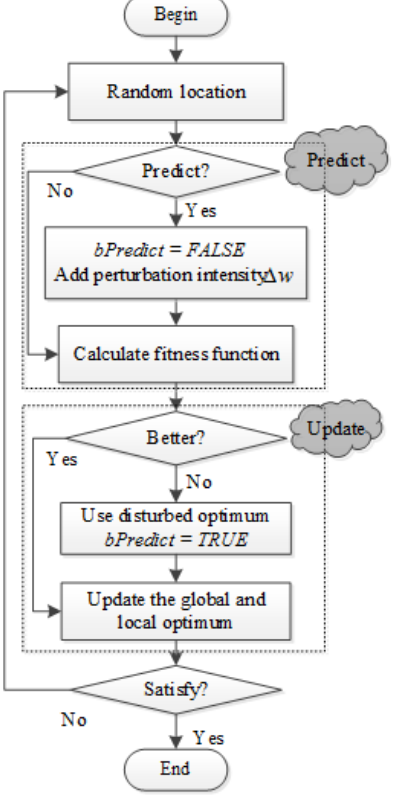
Figure 3. Flowchart of improved fruit fly optimization algorithm (IFOA).